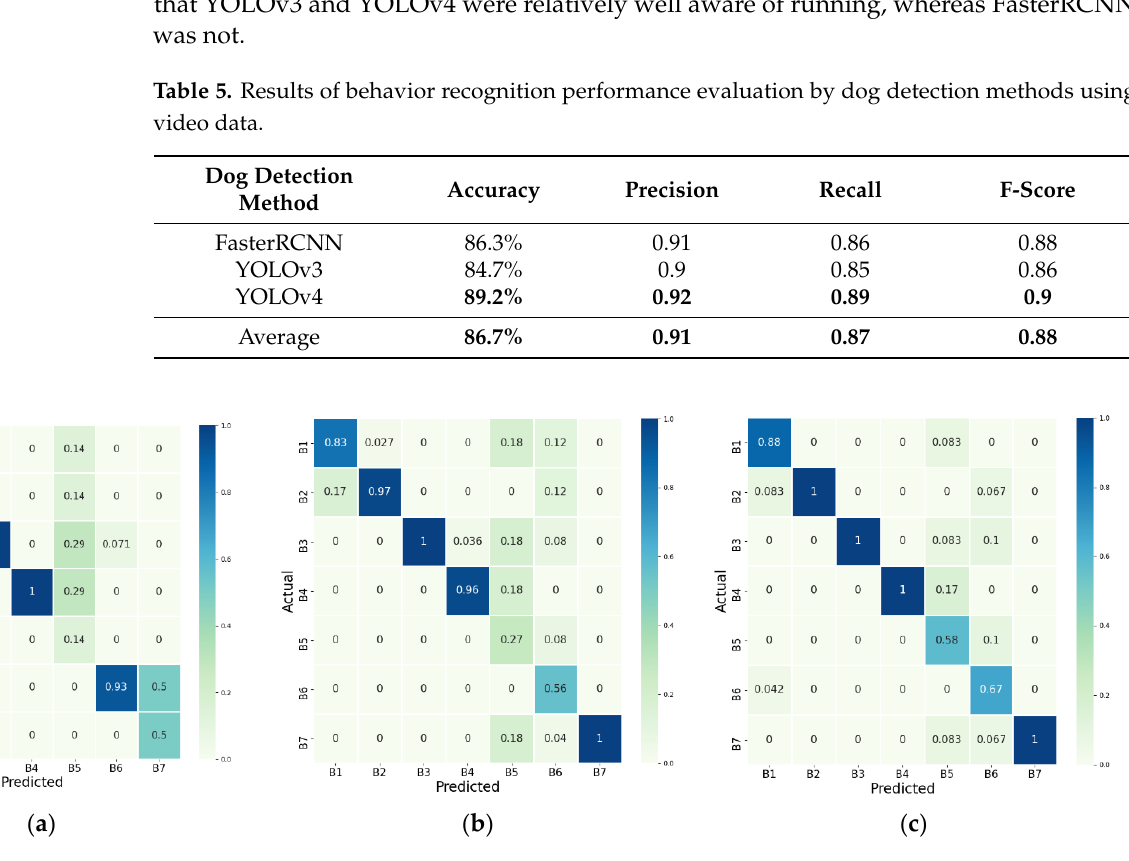
Figure 8. Confusion matrix of behavior recognition by dog detection methods using video data: ( a ) FasterRCNN; ( b ) YOLOv3; ( c ) YOLOv4. The bluer the cell, the higher the accuracy of dog recognition.